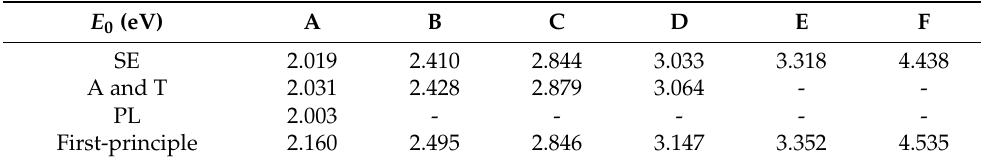
Figure 2. Characterization results of the CVD single-crystal monolayer WS 2 sample on the sapphire substrate: ( a ) PL spectrum, the inset is a scheme of the lattice structure; ( b ) Raman spectrum; ( c ) absorption and transmission spectra, where uppercase letters A–D represent the feature peaks in the absorption spectrum; ( d ) the AFM image, the inset shows the height curve of the white line across the sample; ( e , f ) the SEM images, indicating an example grain size of 65 µm. Table 1. Comparison of CP center energies E 0 obtained from the SE, absorption and transmission (A and T), PL and first-principle